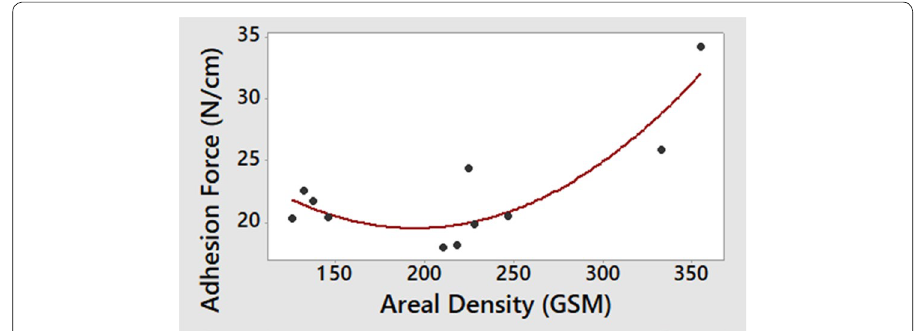
Fig. 4 Effect of areal density on adhesion force